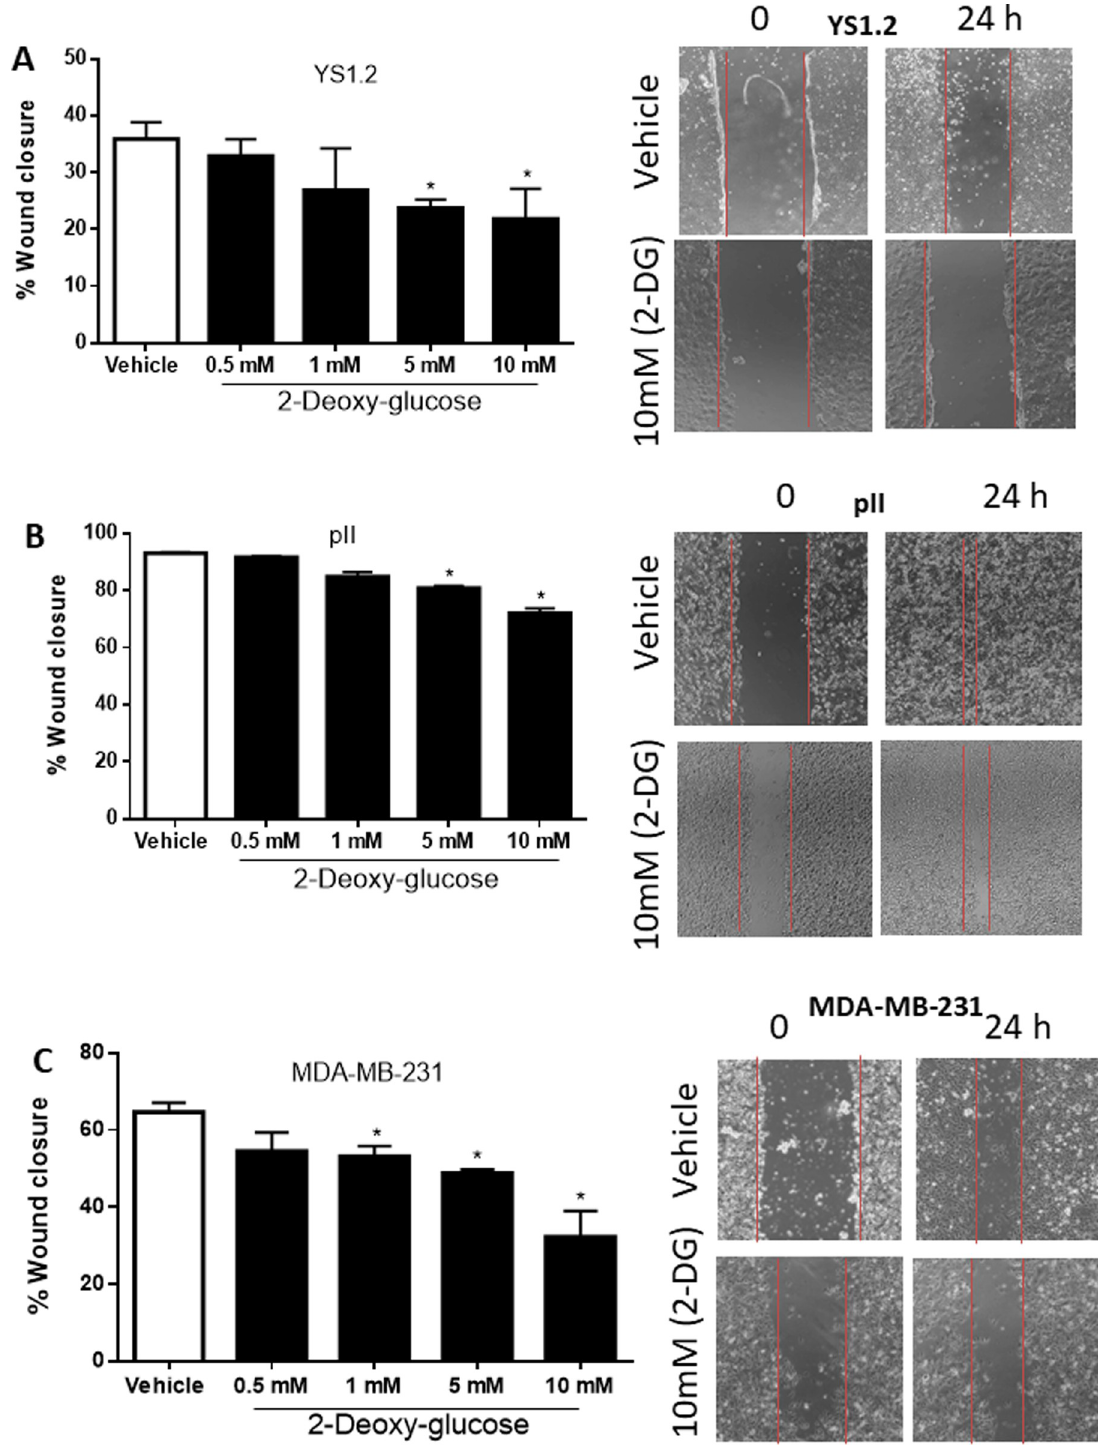
Fig 7. Effect of 2-deoxy glucose on cell motility. Motility of the YS1.2 (A), pII (B), and MDA-MB-231 (C) cells in response to treatment with various concentrations of 2-DG or vehicle, was measured using the wound healing assay. Histobars represent means ± SEM of at least 3 independent experiments. � denotes significant difference from vehicle treated cells, with p < 0.05.